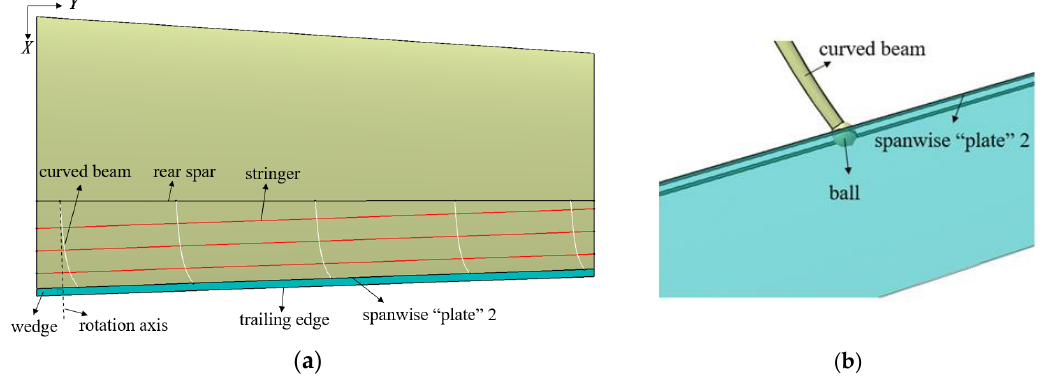
Figure 4. Improved deflection mechanism: ( a ) top view; ( b ) the ball is inserted into the spanwise “plate” 2.